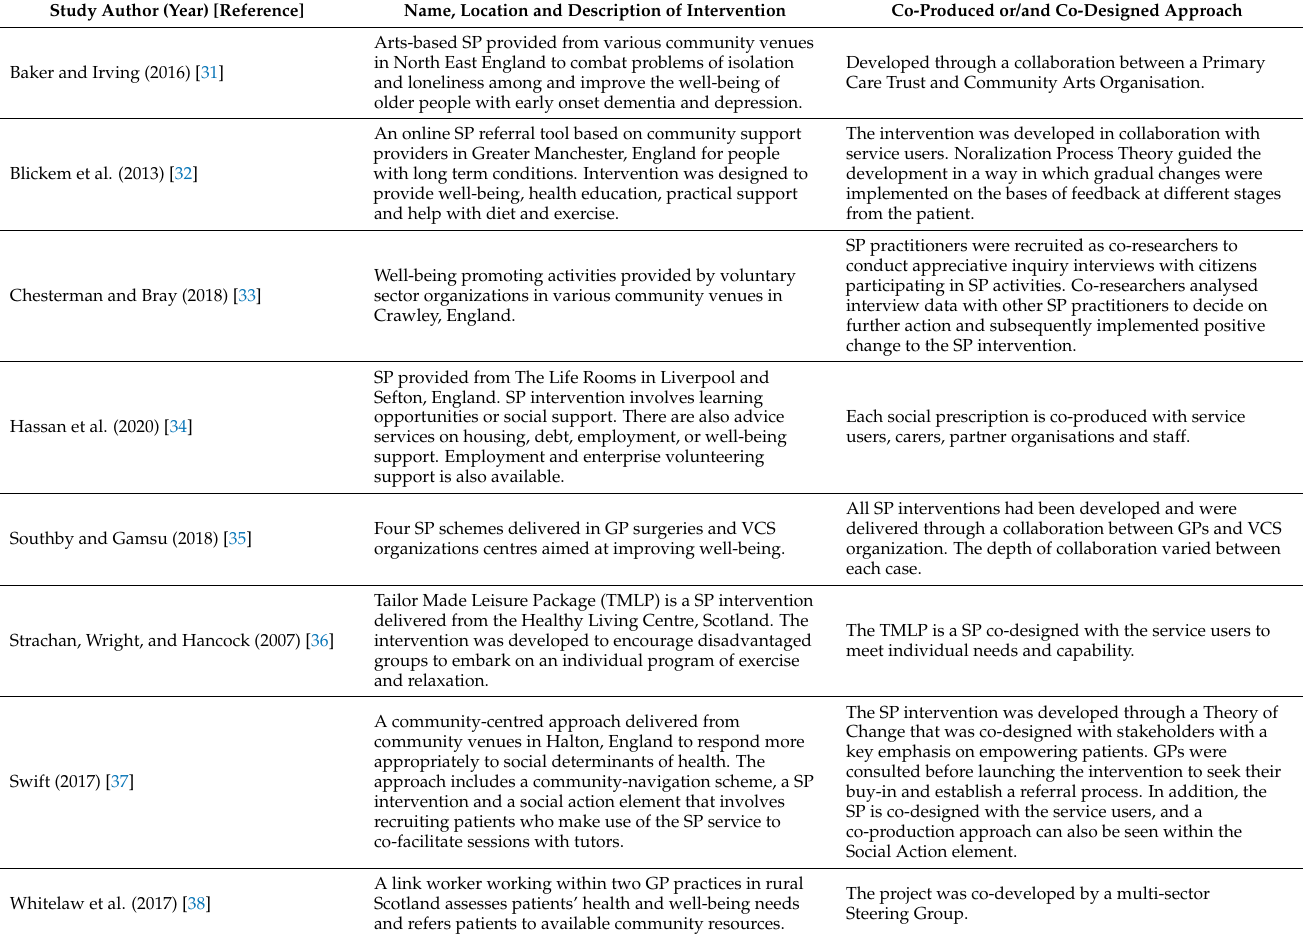
Table 3. SP intervention characteristics and